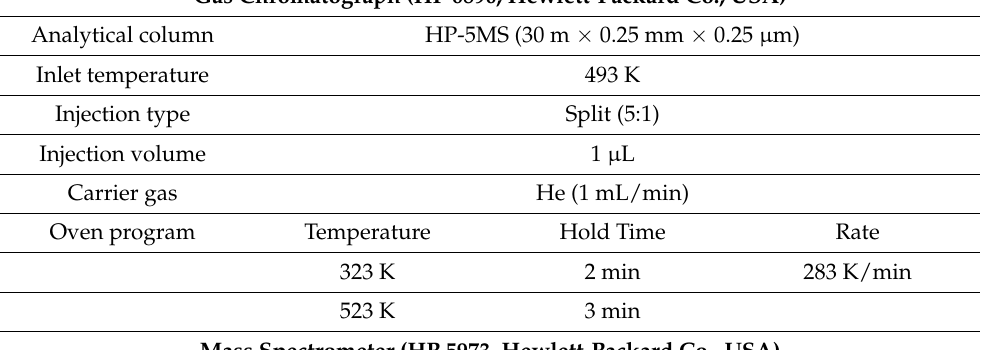
Table 2. Operation specifications for